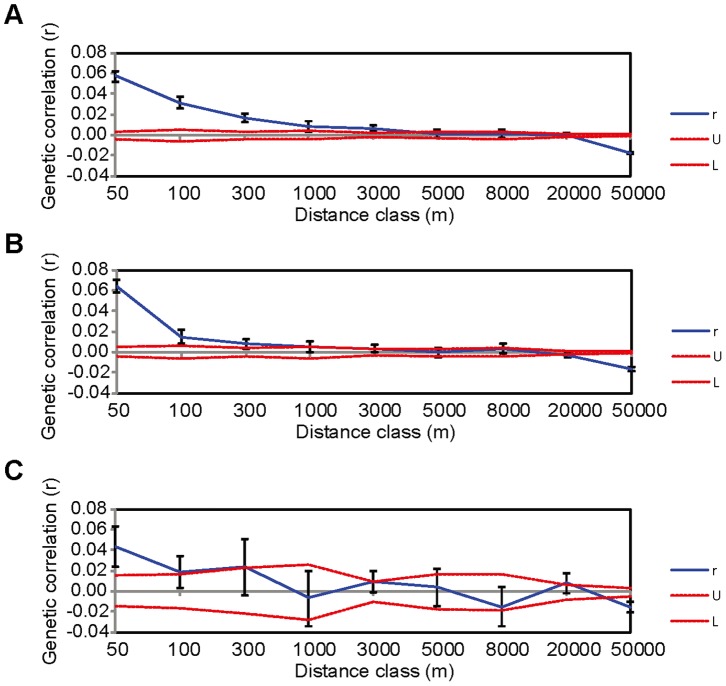
Correlogram plots of the genetic autocorrelation coefficient (r) as a function of distance.Upper (U) and lower (L) confidence limits (two red lines) bind the 95% confidence interval about the null hypothesis of no spatial structure for the combined data set as determined by 1000 permutations. (A) all individuals (n = 296), (B) females (n = 227), (C) males (n = 69).